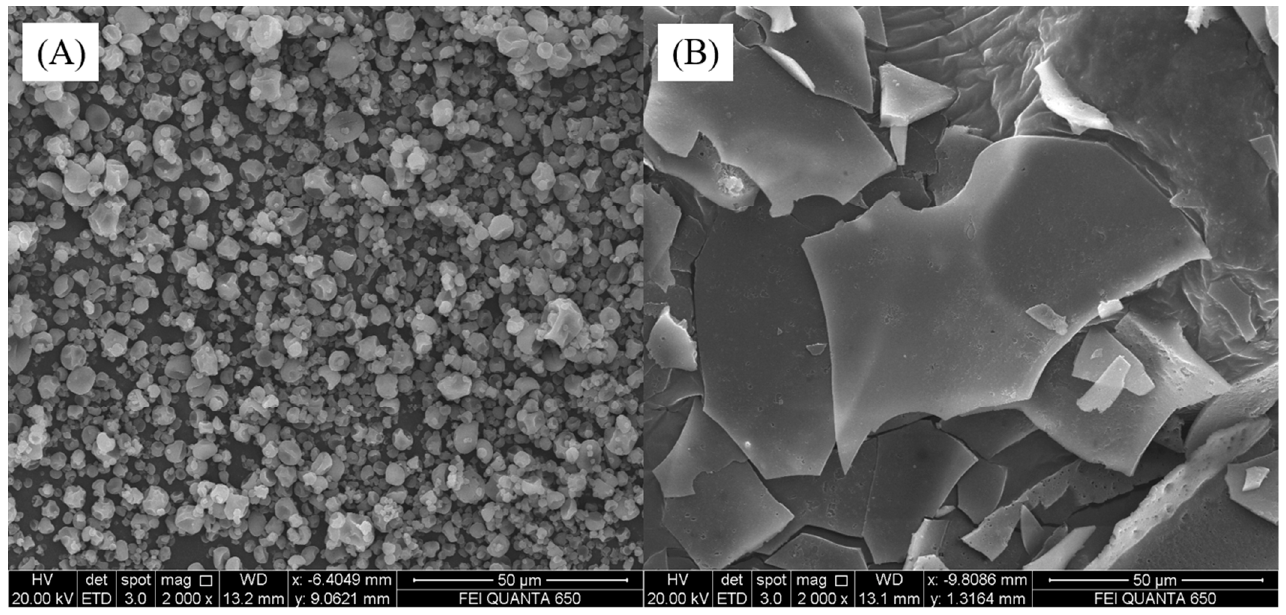
Figure 1. SEM image of SPH-SD ( A ) and SPH-FD ( B ).